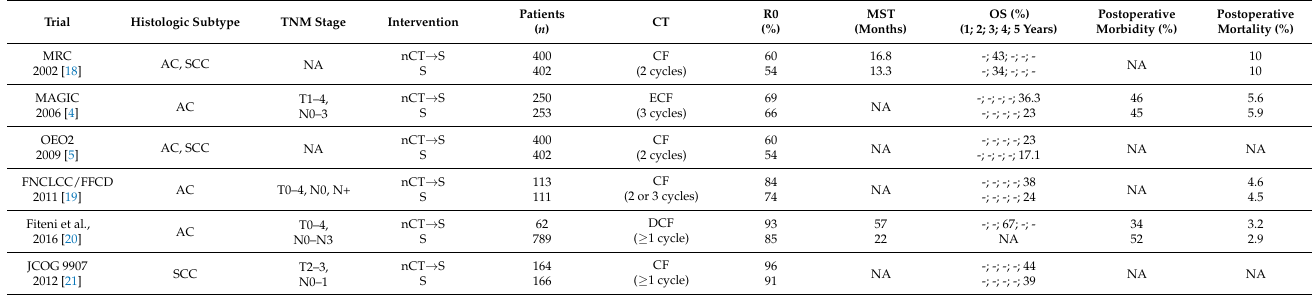
Table 1. Clinical trials of nCT versus surgery alone for EC